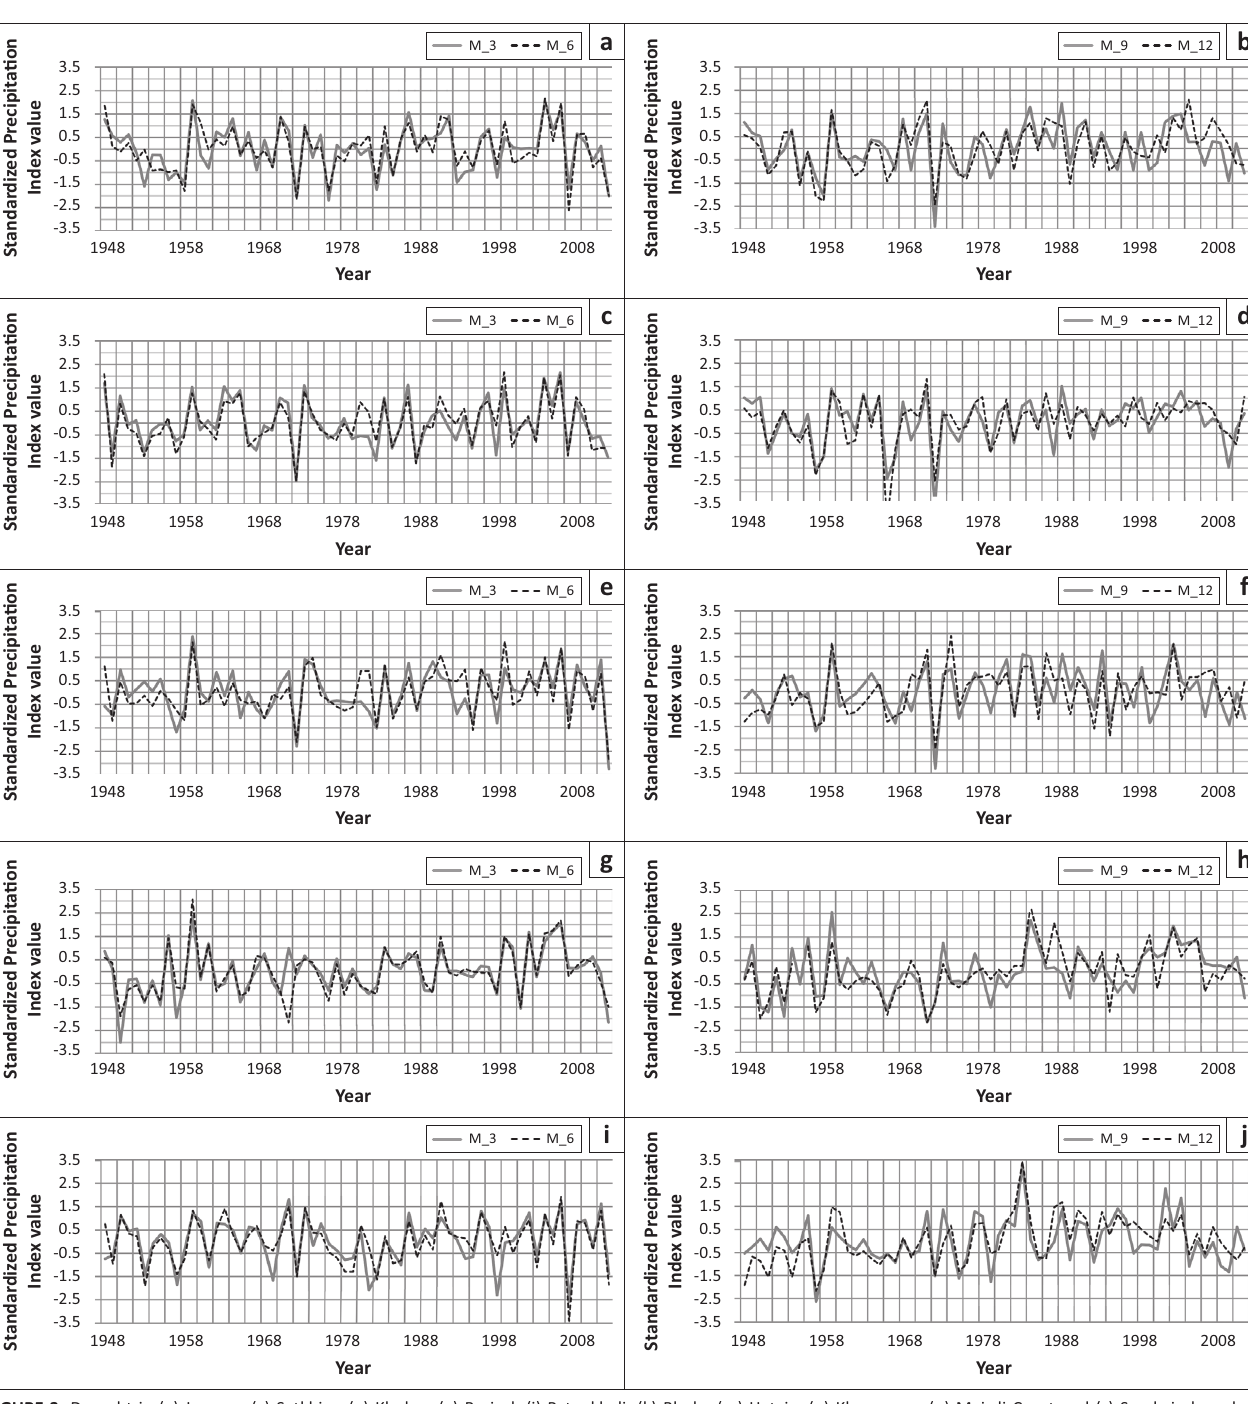
Figure 3 continues on the next page